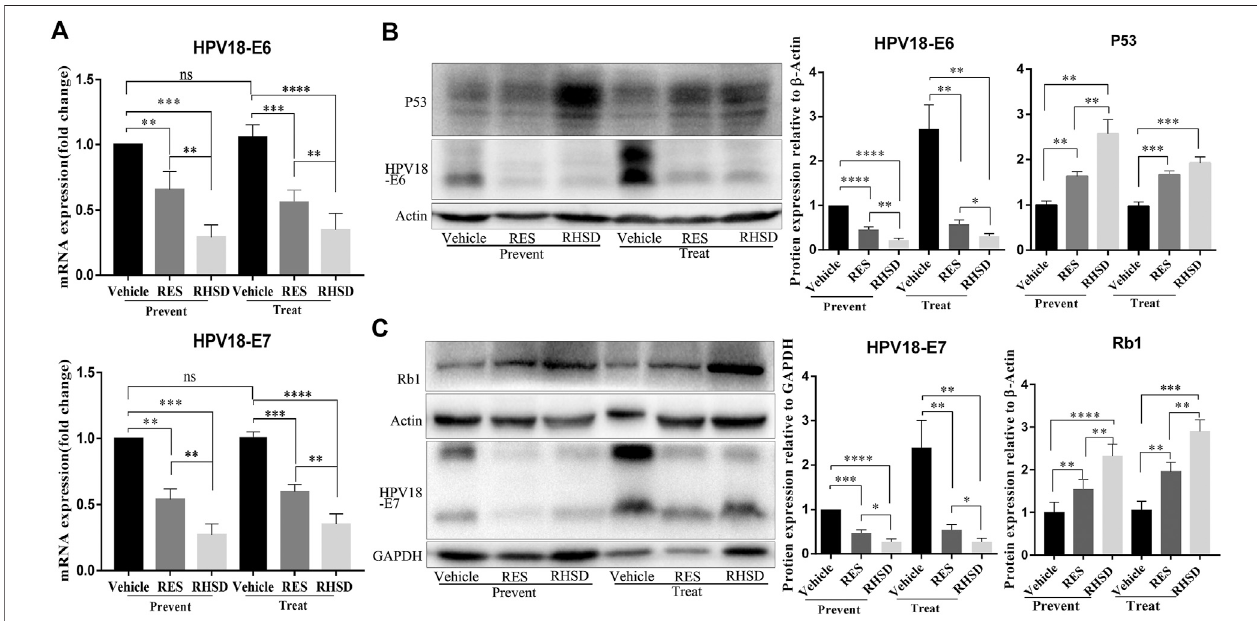
FIGURE6| ExpressionofHPV18E6,E7,P53,andRb1incervicalcancertissuesofmicemodelafterRESorRHSDtreatment (A) HPV18E6andE7mRNAlevelsin cancertissues were determined using real-time RT-PCR (B) HPV18 E6and P53protein levels incancertissuesweredeterminedbyWesternblot. Thehistogram on the right is the quantitative analysis of the results (C) HPV18 E7 and Rb1 protein levels in cancer tissues were determined by Western blot. The histogram on the right is the quantitativeanalysisoftheresults. Thedatawerepresented asthemean ± S.D.forthree differentexperiments performed intriplicate. ** p < 0.01,*** p < 0.001,and **** p <